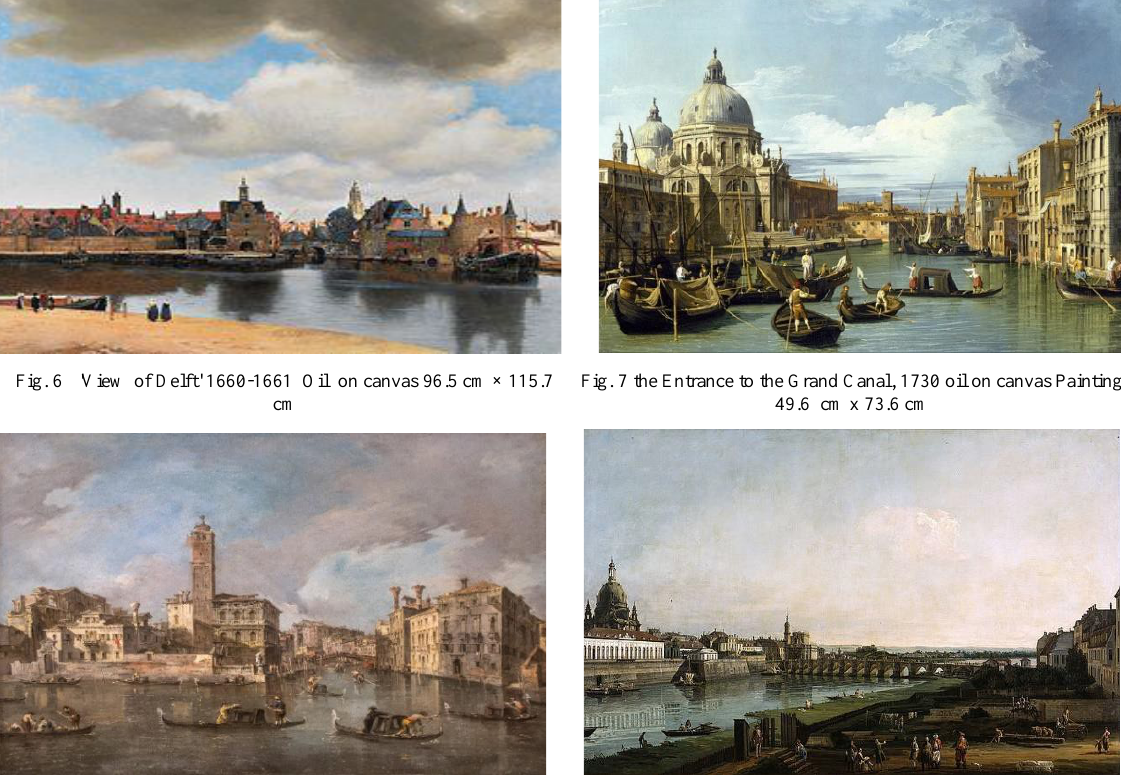
Fig. 8 View on the Grand Canal at San Geremia, Venice(1760-65) Fig. 9 Dresden from the Right Bank of the Elbe, 1747 oil on canvas